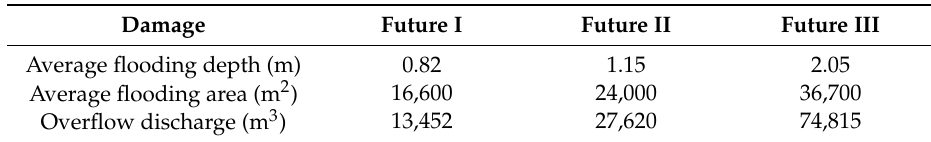
Table 3. Projected damage for each target